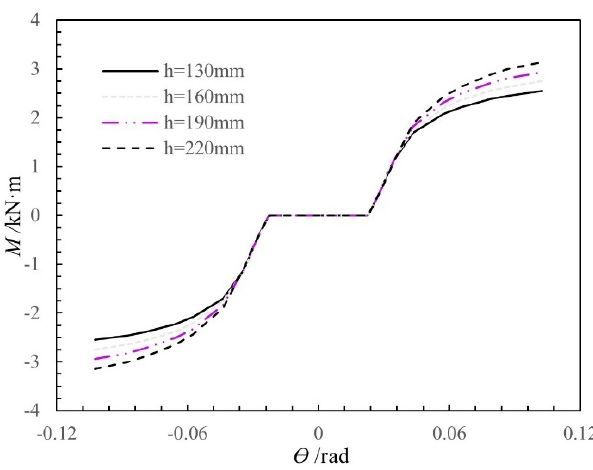
Figure 17. Moment-rotation curves of SMTJ/WP for different depths of the tenon.